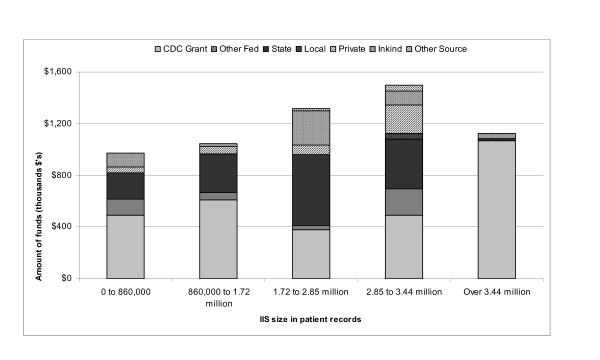
Average amount of annual expenditures* by funding source† and immunization information system size§, 1998-2002.*Dollars inflated to 2002 dollars.   †Sources of funds included immunization grants from the Centers for Disease Control and Prevention (CDC), funding support from other CDC offices and other federal agencies, state government funds, local government funds, private donations, in-kind support, and other sources of funds (e.g., user fees).   §Cut points in immunization information system size are based on five equal intervals between 0 and 3.4 million records